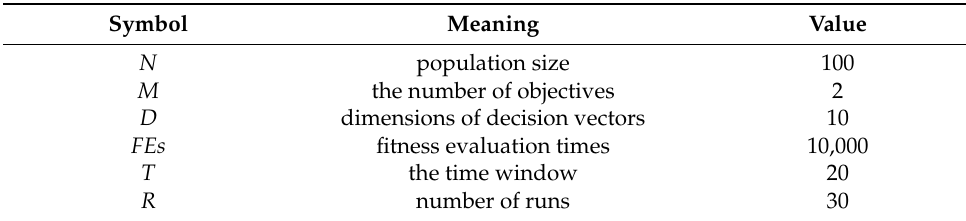
Table 3. The general parameters of all